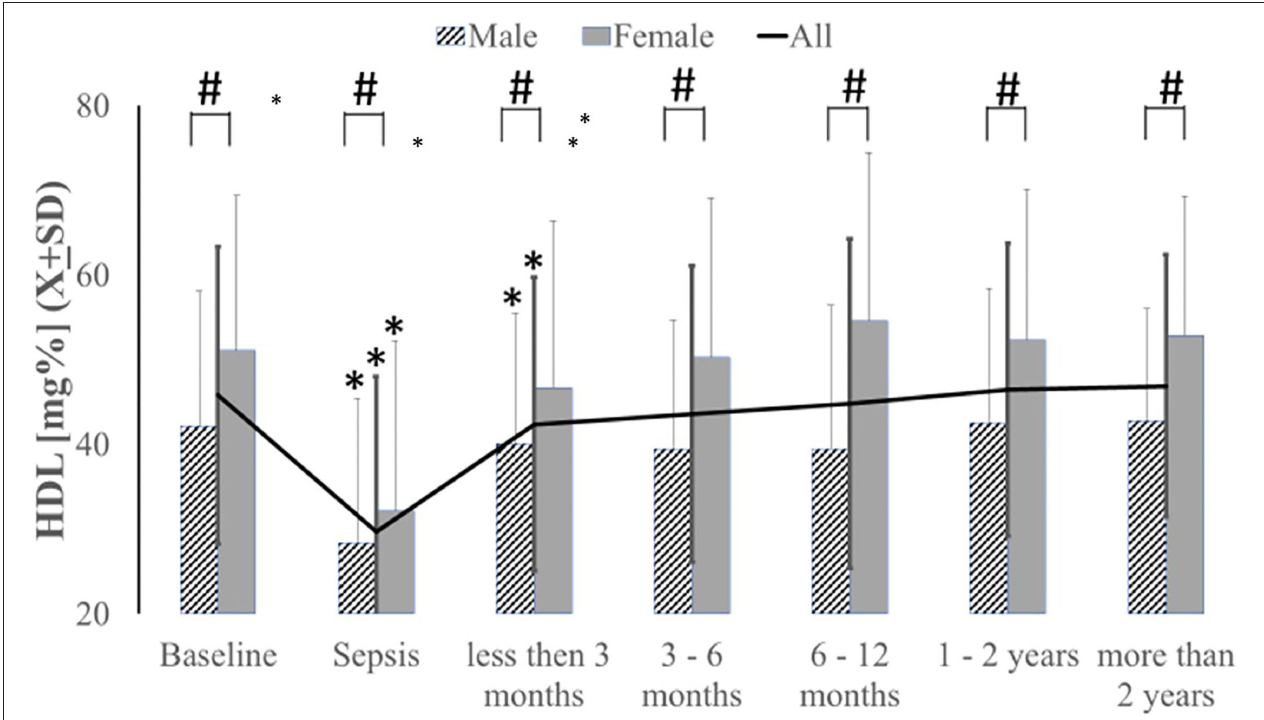
FIGURE 2 | Serum HDL levels were decreased acutely during sepsis and slowly recovered within three months after sepsis with significantly less recovery female subjects. * p < 0.05 as compared to baseline, # as compared between genders.